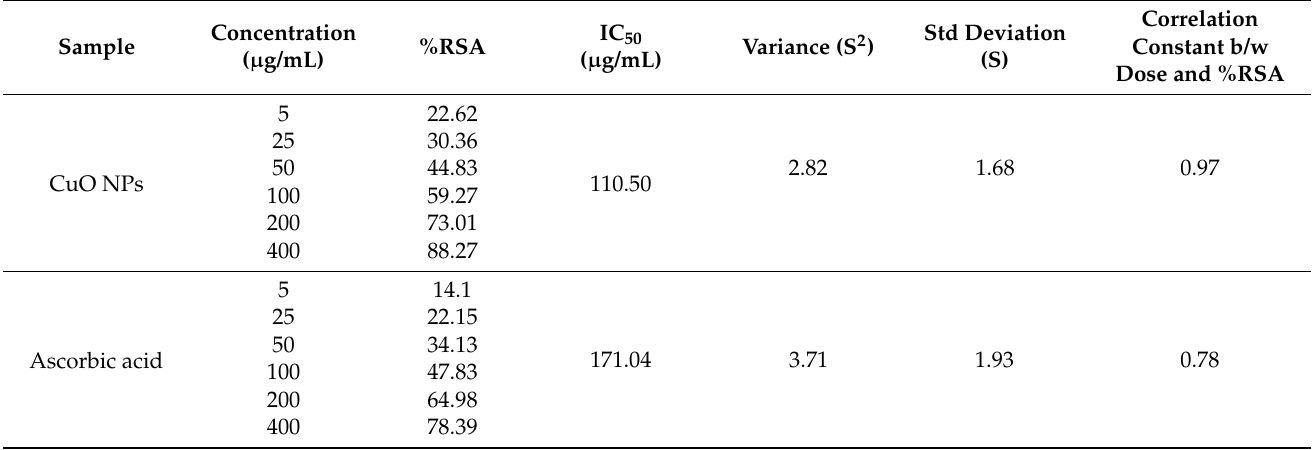
Table 2. Antioxidant activity of CuO NPs against ABTS free radicals and statistical